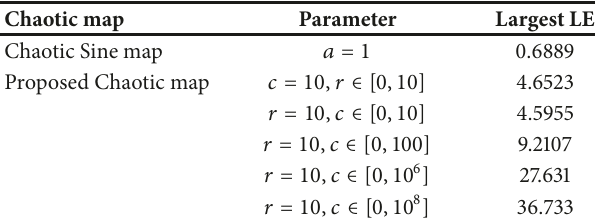
Table 1: Comparison of Lyapunov exponents for two chaotic